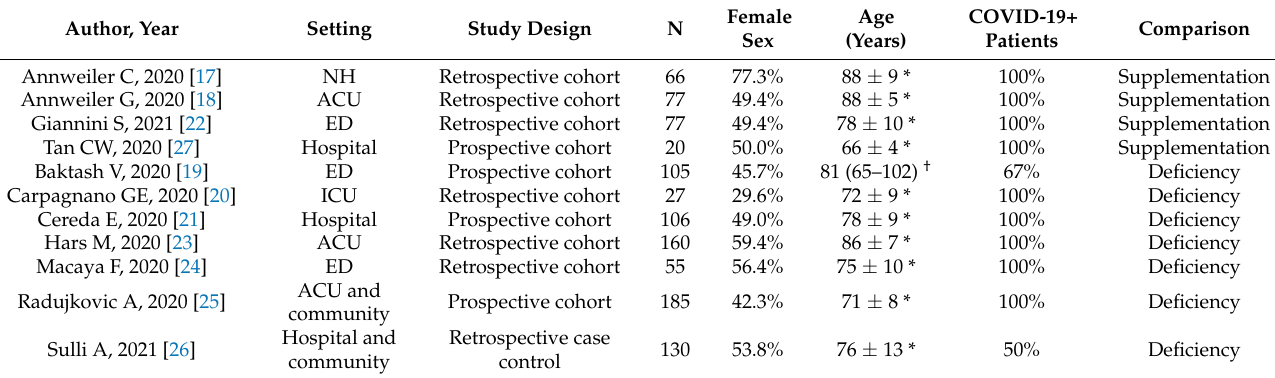
Figure 1. PRISMA (Preferred Reporting Items for Systematic Reviews and Meta-Analyses) flow diagram of the records included in the systematic review. Table 1 summarizes the characteristics of the studies included in the review. All stud- Table 1. Description of the 11 studies included in the systematic